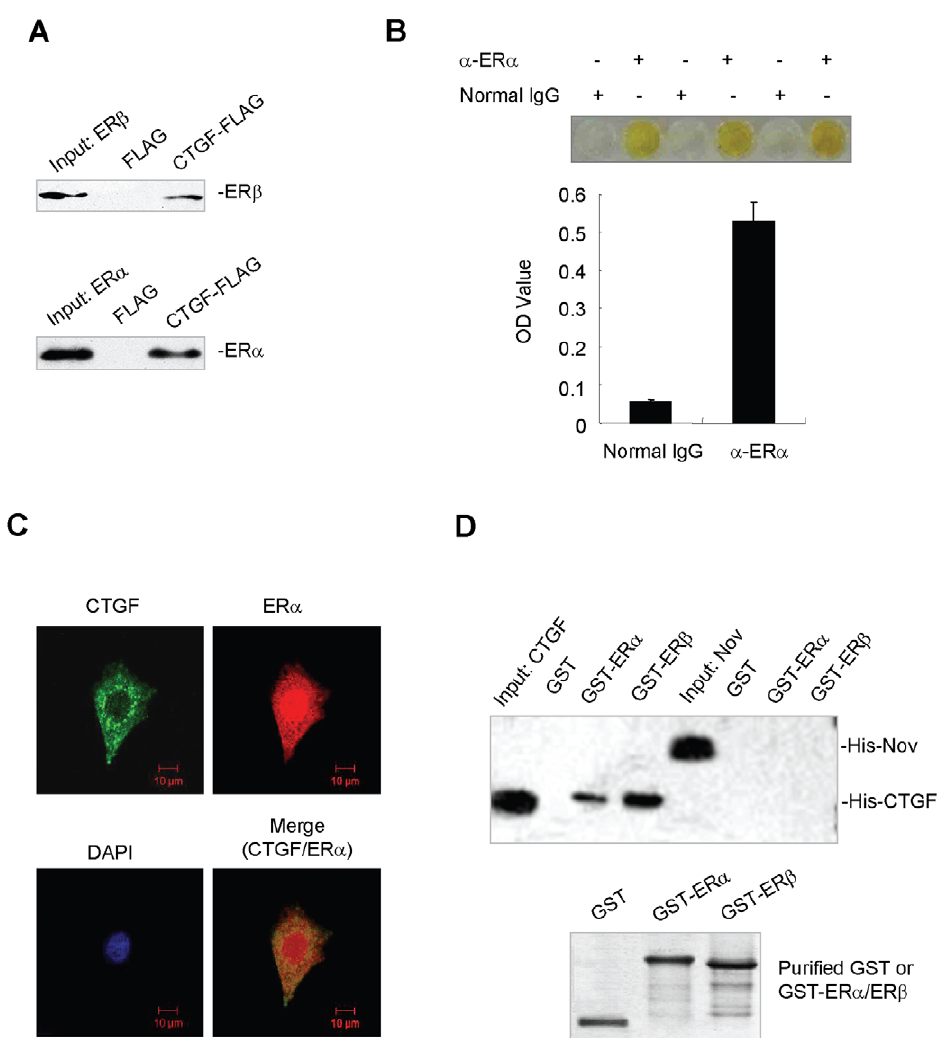
Figure 2. CTGF interacts with ER a and ER b in mammalian cells and in vitro. (A) Interaction of CTGF with ER a and ER b in mammalian cells. MCF7 cells were transfected with expression vector for FLAG-tagged CTGF (CTGF-FLAG) or empty (FLAG) plasmid in the presence of 17 b -estradiol (E2). Conditioned medium from the FLAG- or CTGF-FLAG-transfected cells was incubated with MCF7 cell lysates. Immunoprecipitation (IP) was performed using anti-FLAG monoclonal antibody, and immunoblotted (IB) with anti-ER b or anti-ER a . (B) Physiological interaction of CTGF with ER a by ELISA. CTGF monoclonal antibody-coated wells were incubated with MCF7 cell lysates together with conditioned media, followed by incubation with rabbit anti-human ER a antibody or normal rabbit serum. Absorbance at 415 nm (OD value) was measured with a plate reader. (C) Colocalization of endogenous CTGF with ER a . MCF7 cells were treated with 10 nm E2, immunostained for CTGF (green) and ER a (red), and counterstained for DNA with DAPI (blue). The images were captured by confocal immunofluorescence microscopy; original magnification, 6 100. (D) Direct interaction of CTGF with ER a and ER b . Glutathione–Sepharose beads bound with GST-ER a /ER b or with GST were incubated with purified His-tagged CTGF or Nov. After washing the beads, the bound proteins were subjected to SDS–PAGE and Western blot with anti-His